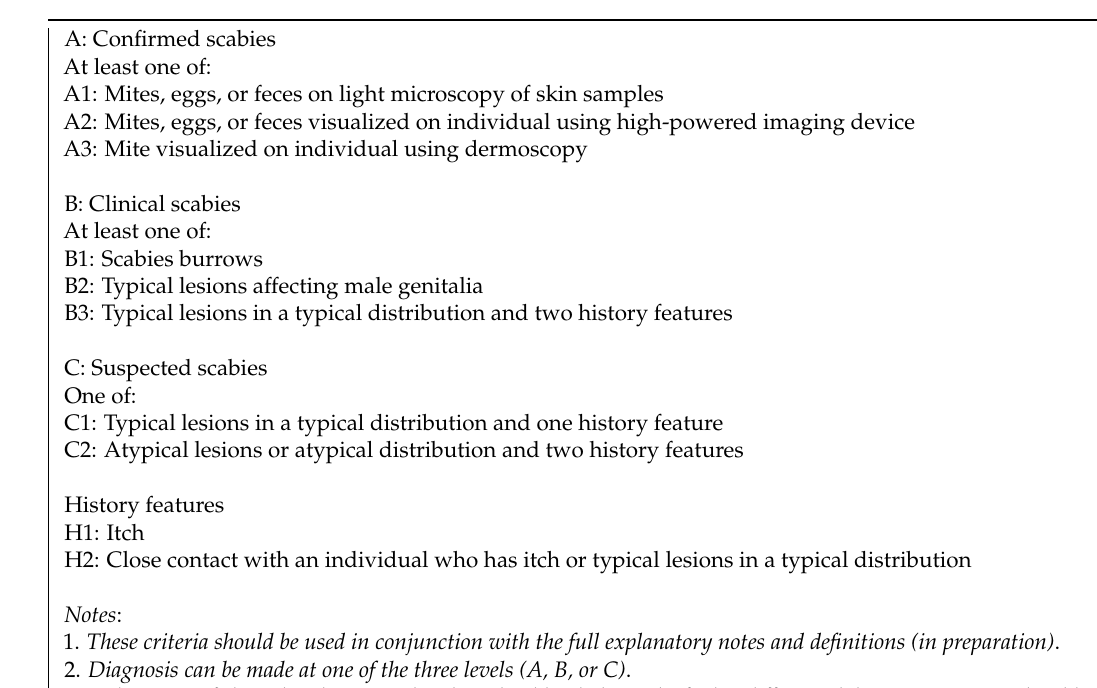
Table 1. The 2018 International Alliance for the Control of Scabies (IACS) criteria for the diagnosis of